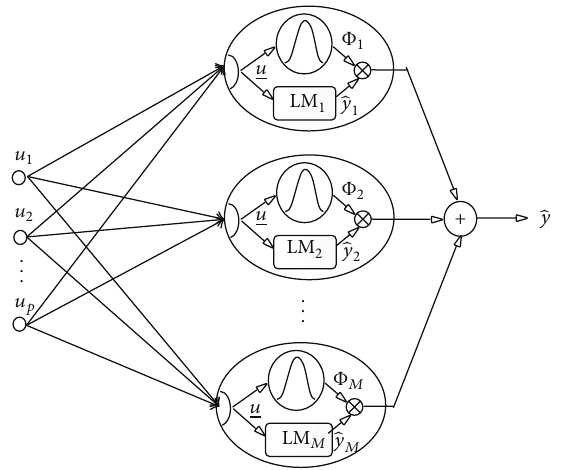
Figure 1: Structure of LNF with 𝑝 inputs and 𝑀 local